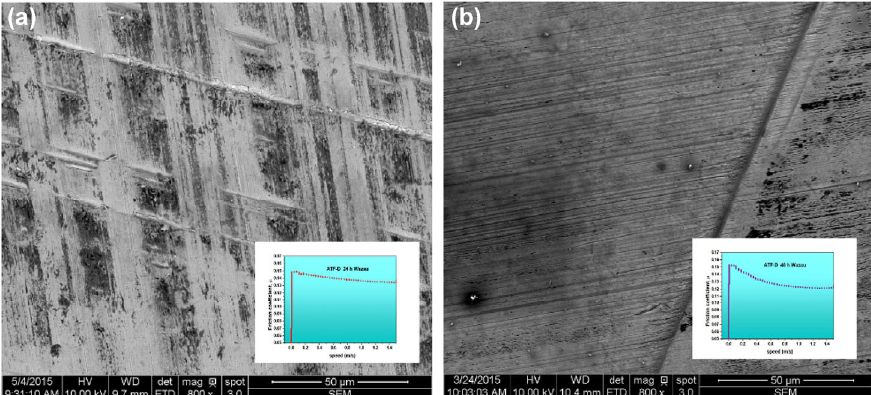
Fig. 6 SEM images of post-test steel disc surfaces after (a) 24 h and (b) 48 h Wazau durability tests for ATF-D.